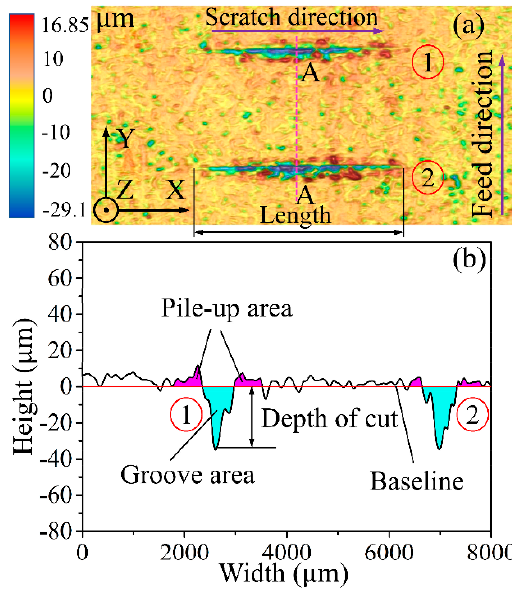
Figure 4. The measurement of scratches cut by single grit: ( a ) morphology of scratched workpiece surface; ( b ) cross-sectional profile of scratches.